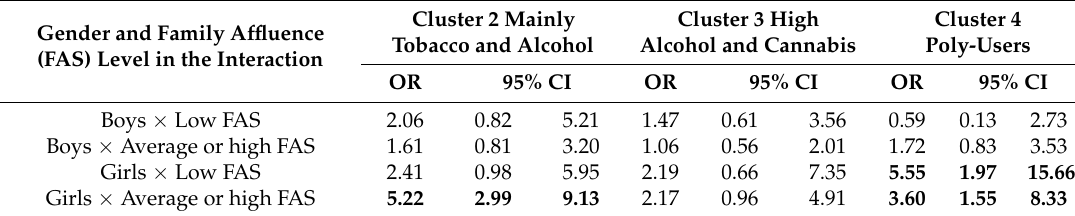
Table 4. Interaction effect estimates from the alternative multinomial logistic regression * with main effects (age, gender) and three-way interaction (perceived academic achievement × gender ×